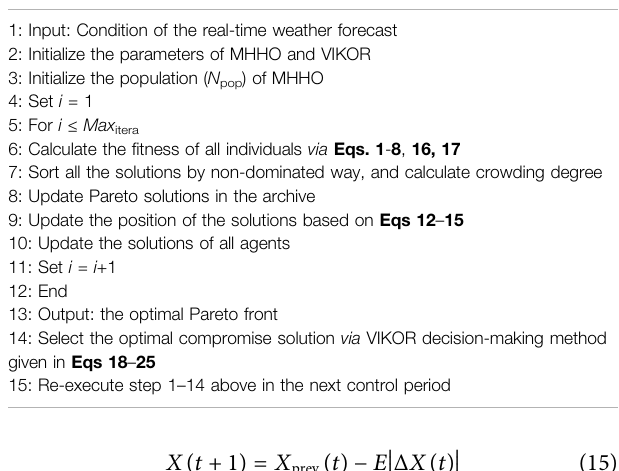
TABLE 1 | The procedure pseudocode of MHHO for PV station array recon fi guration.